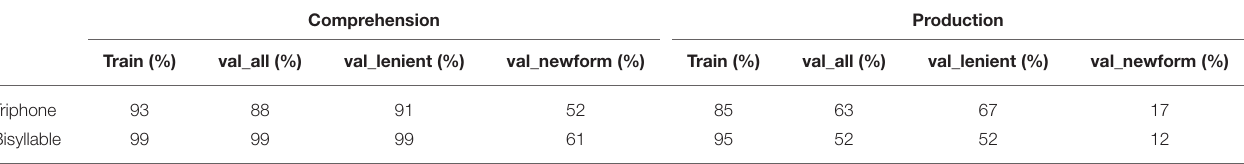
TABLE 6 | Comprehension and production accuracy for train and validation datasets, which are split in such a way that no novel cues are present in the validation set. Comprehension